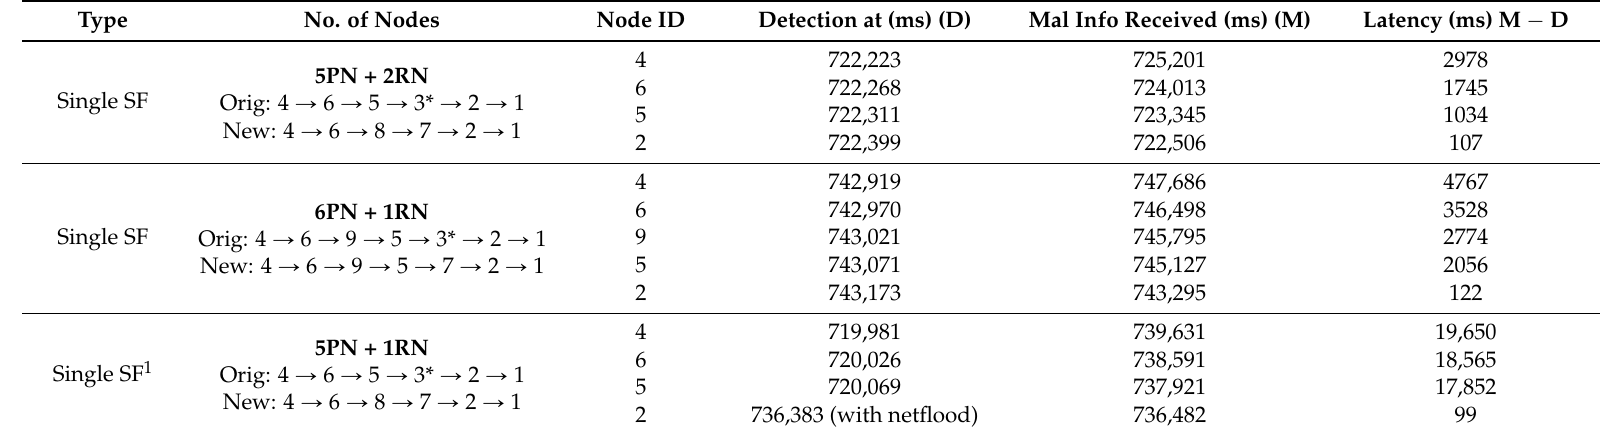
Table 3. Single Selective Forwarding.